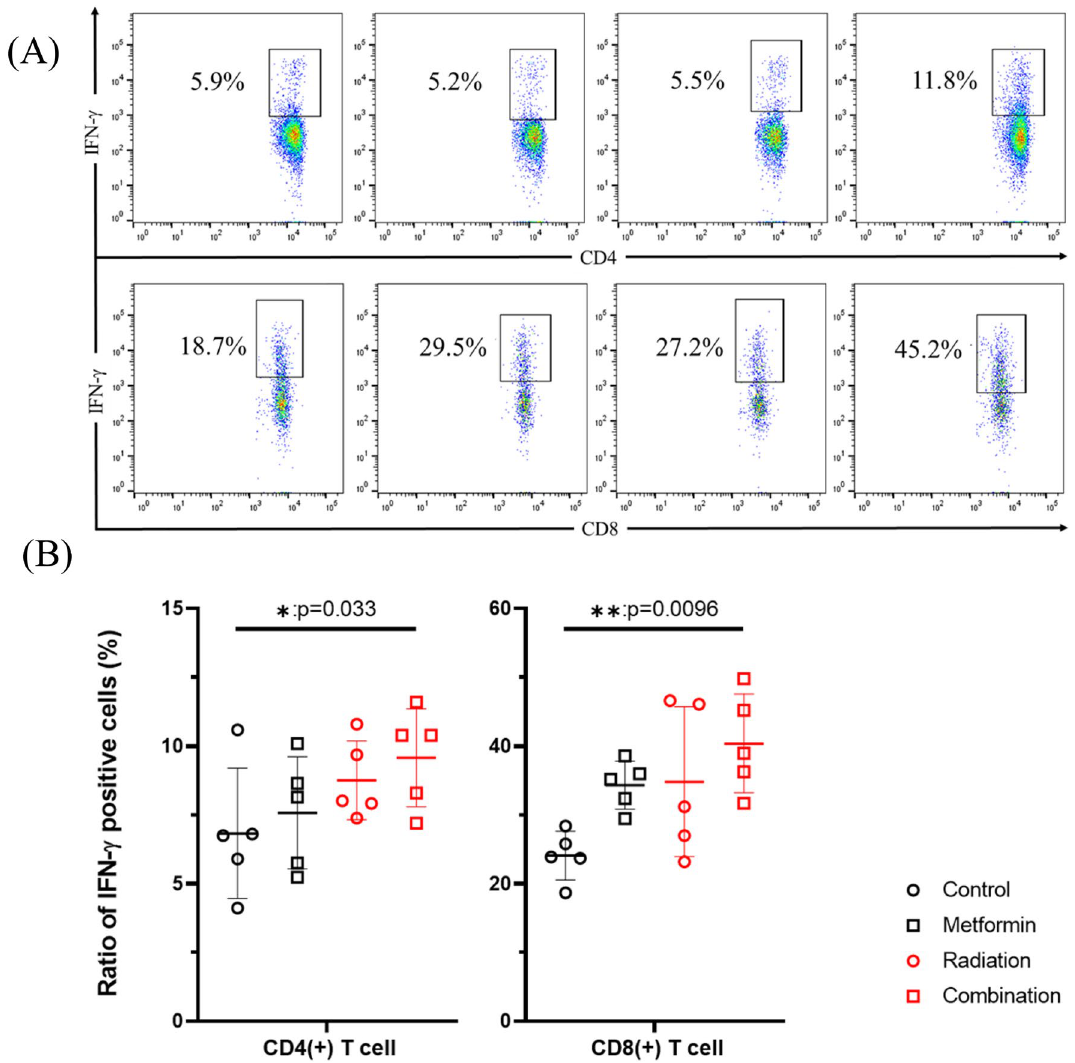
Figure 6. Splenocytes harvested on day 28 were cultured in the presence of 50 ng/ml PMA and 1 μg/ml ionomycin with 5.0 μl/mL brefeldin A for 4 h and cells positive for intracellular IFN-γ in these cell populations were evaluated with flow cytometry ( A ): Representative profiles of intracellular staining of IFN-γ ( B ) Data are shown as mean ± standard deviation of 5 mice in one of the 2 experiments. * p < 0.05, ** p <